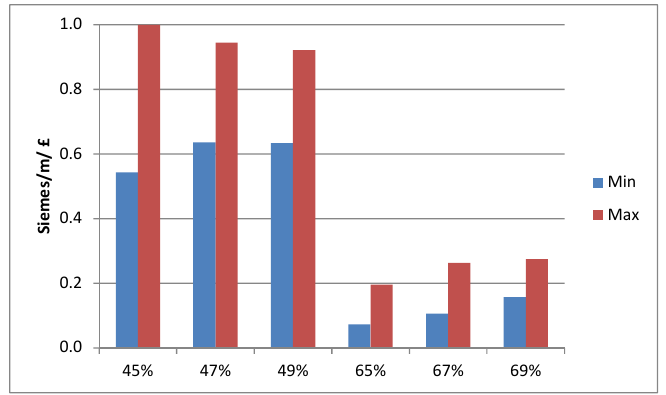
Figure 11. The range of conductivity/unit cost obtained with each